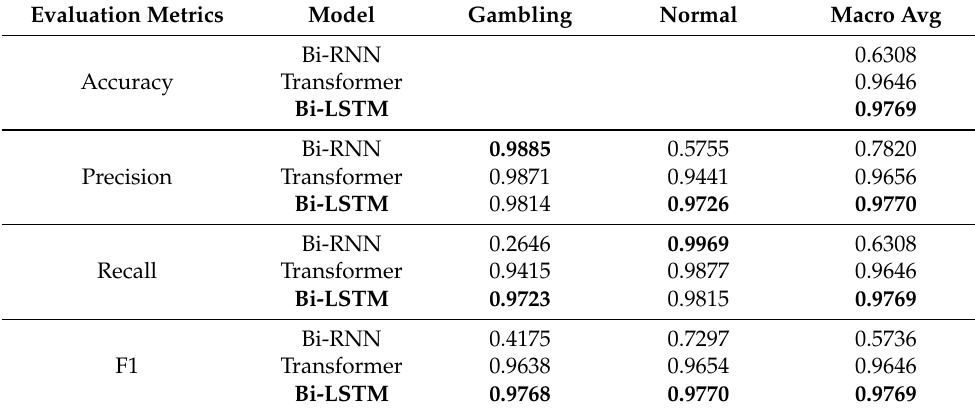
Table 4. Results of Bi-RNN, Transformer, and Bi-LSTM.